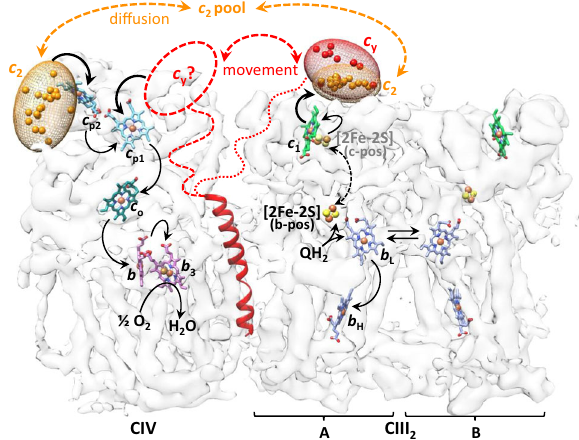
Fig. 6 Proposed cyt c 2 and cyt c y- binding regions of CIII 2 CIV and electron transfer pathways. The likely binding regions of cyt c 2 and cyt c domains of c fi ned by XL-MS-guided y (orange and red ellipsoids, respectively), de docking, are depicted by the distributions of their heme-Fe atoms on the transparent map SC-2A of CIII 2 CIV. Only the positions that are within 25 Å of heme c 1 of CIII 2 or heme c p2 of CIV are indicated. The cofactors together with the TMH of cyt c y are shown as in Fig. 5. The linker region (indicated by dotted or dashed lines) between the TMH and the cyt domain of c y is not resolved in the cryo-EM map. The proposed electron transport pathways are shown by thicker black arrows: upon QH 2 oxidation by CIII 2 , cyt c y that is integral to CIII 2 CIV receives an electron from heme c 1 . It then moves (double-headed dashed red arrow) to an unde fi ned binding region (dashed oval with c y ?) on CIV, where it delivers the electron to the nearest heme c p1 Fig. 5 Organization of CIII 2 CIV cofactors and redox partners. a The of CIV. Similarly, cyt c 2 that is peripheral to CIII 2 CIV also receives an cofactors are shown inside the transparent map SC-2A of CIII 2 CIV with the electron from heme c 1 , diffuses away to reach CIV, and conveys it to heme same subunit colors as in Fig. 2: hemes b L and b H (periwinkle), heme c 1 c c p2 . The canonical electron transfers occurring from QH 2 to heme 1 in CIII 2 , (green), hemes c p1 and c p2 (light blue), heme c o (dark green), hemes b and and from heme c p1 to O 2 in CIV, are indicated by thinner arrows. The double b – red spheres. In all 3 (purple). The [2Fe-2S] clusters are shown as yellow headed dashed black arrow depicts the movement of the [2Fe-2S] of FeS cases, the distances (heme-Fe to heme-Fe) between the heme cofactors protein from the b position (b-pos, black, solid spheres) to the c position (c- are indicated. The positions of docked cyt c 2 and cyt domain of c y are pos, gray, transparent spheres) in CIII 2 during QH 2 oxidation. A possible indicated as orange (heme c 2 ) and red (heme c y ) spheres, respectively, electron equilibration between the two heme b L of CIII 2 is indicated by representing their heme-Fe atoms. All heme-Fe atoms corresponding to the double arrows, and the electron transfer steps subsequent to heme b H top 50 docking positions for cyt c 2 on CIV are shown as solid (<25 Å) or reduction are not transparent (>25 Å) spheres, depending on their distances to heme c p2 . In the case of CIII 2 , only the docking positions of cyt c 2 and cyt c y on monomer A and between the monomers A and B are shown, omitting those located on monomer B. The TMH of cyt c y is shown in red at CIII 2 CIV interface. b The heme-Fe atoms of all 50 cyt c 2 models docked onto CIV are plotted as function of their distances from heme c p1 and heme c p2 , with the Fe atoms within 25 Å shown as solid spheres and those beyond 25 Å as transparent spheres. The vast majority of heme-Fe atoms of docked cyt c 2 models are closer to heme c p2 than heme c p1 of CIV. c Top view of the map shown in a is presented to better visualize the distribution of the docked cyt domain of c y on monomer A and between the monomers A and B. In all cases, the heme-Fe atoms are depicted by spheres and colored as indicated above and on the fi gure.